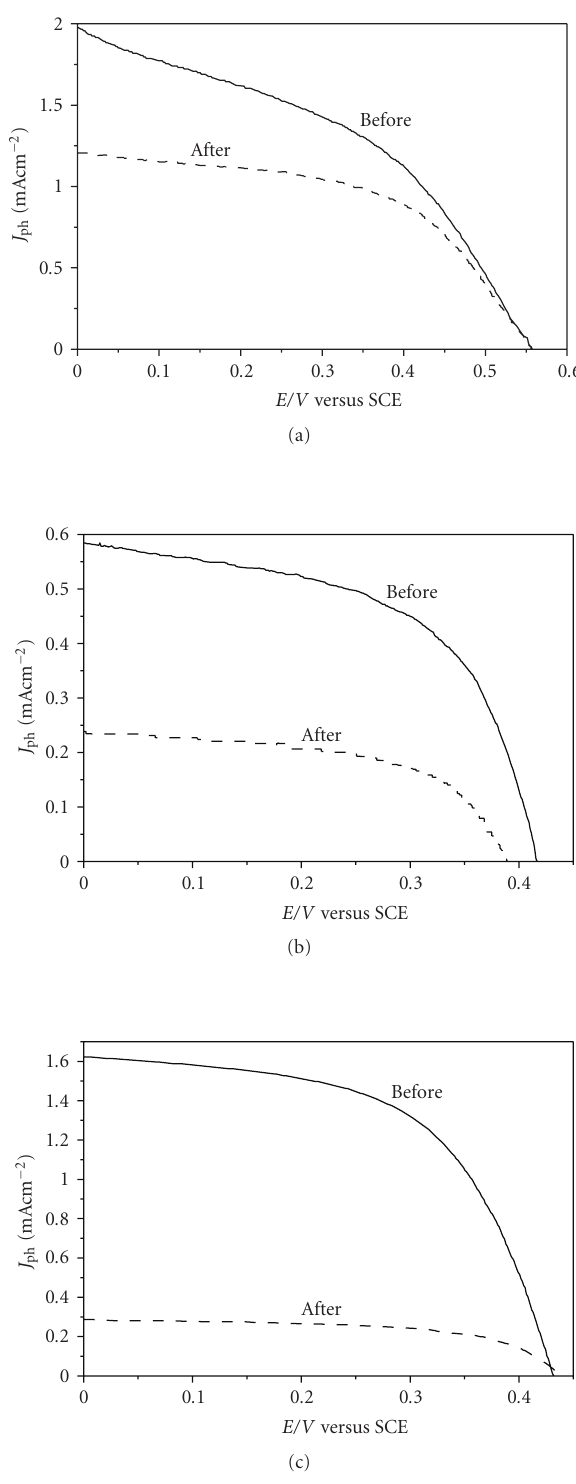
Figure 3: Power output characteristic (photocurrent voltage dependencies) of dye sensitized cells: (a) nanocrystalline ZnO, N3 complex before and after 20 days of simulated solar illumination; (b) nanocrystalline TiO 2 , pyrogallol red before and after 11 days of simulated solar illumination; (c) nanocrystalline TiO 2 , copper chlorophylline before and after 30 days of simulated solar